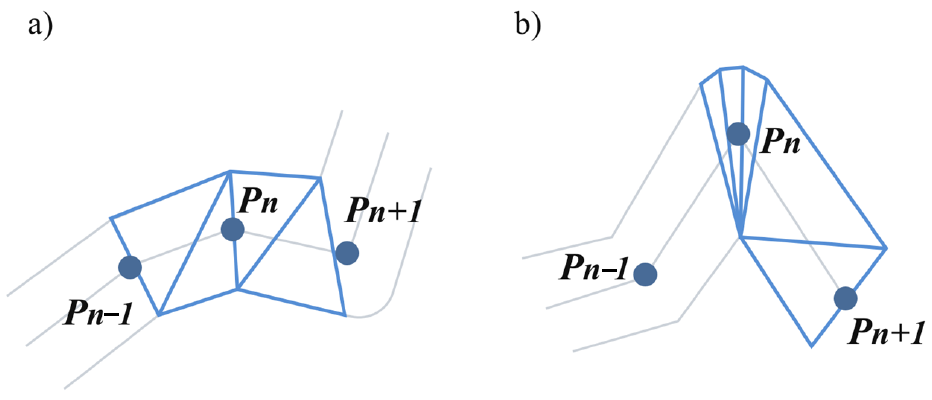
Figure 10. Two types of OpenGL geometric primitives: ( a ) triangle strip; ( b ) triangle fan.